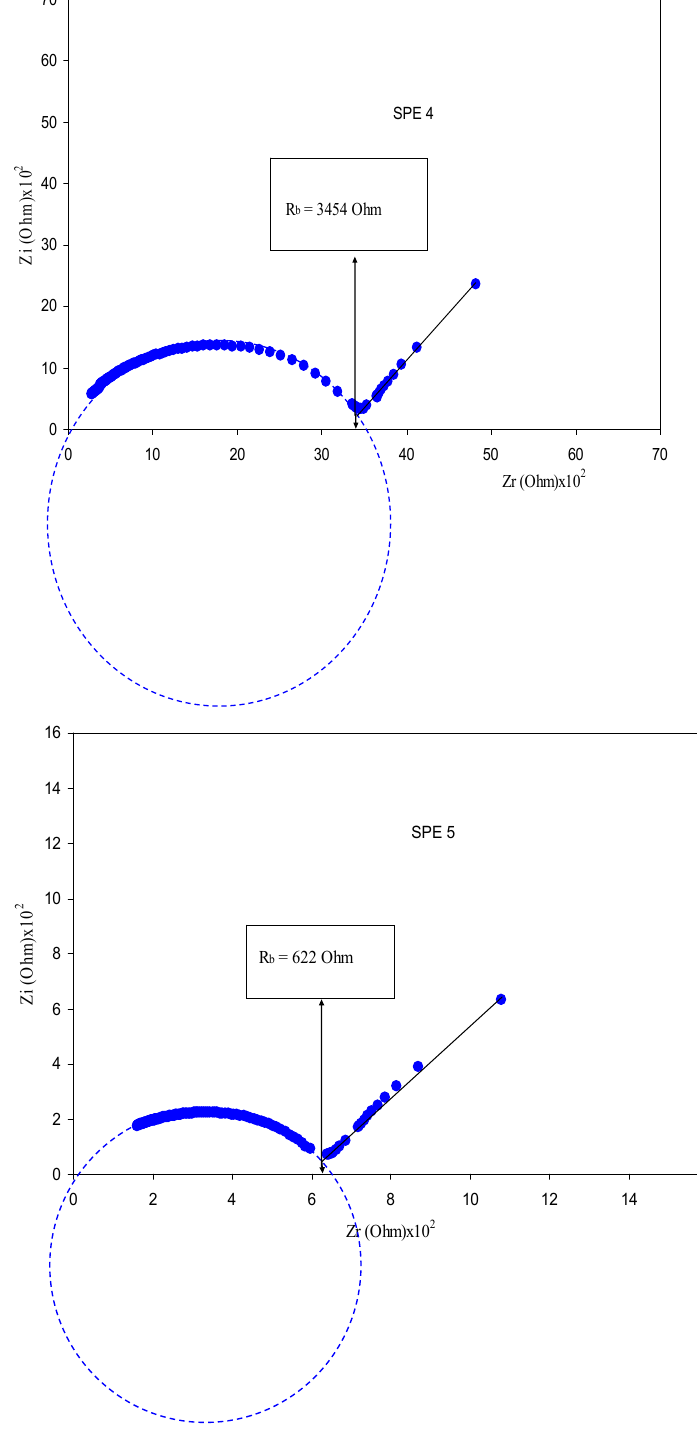
Figure 6. Impedance plots for pure PVA and PVA:AgNt (SPE0 to SPE5) samples. It is obvious that the spike region increases with increasing salt concentration and the high frequency semicircle decreases.